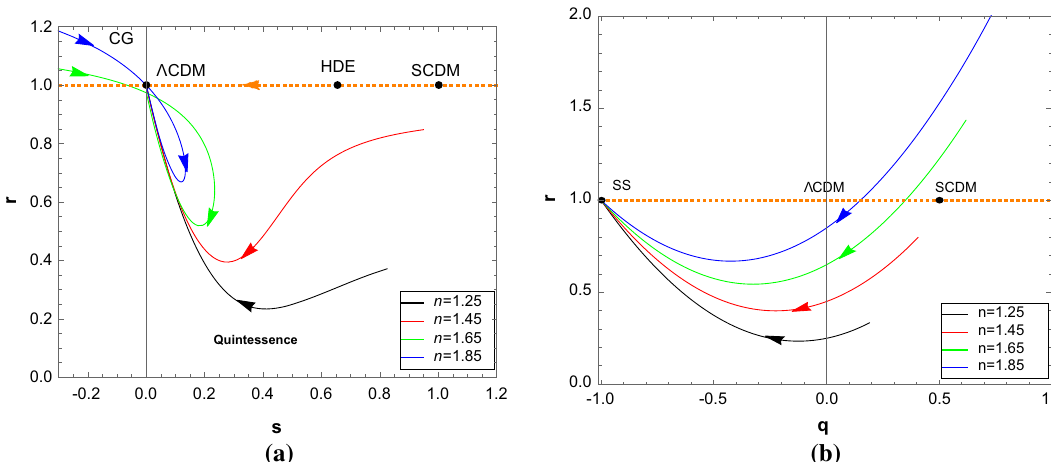
Fig. 7 The s − r and q − r diagrams for our model